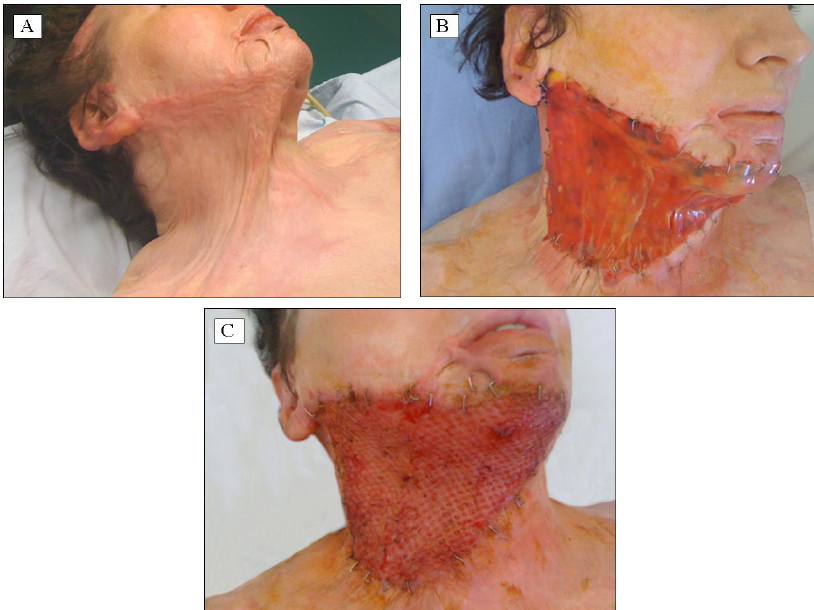
Figure 2. Case 2. A 43-year-old female patient with a 64% burned surface, IIIrd degree after chemical burn (face, neck, anterior thorax, abdomen, upper and lower limbs): ( A ) Hypertrophic scars and contractures involving the right side of the neck, one year after complete healing of burn lesions; ( B ) image of the neck skin, six days after reconstruction with Integra; ( C ) final aspect of the neck, seven days after the second stage of reconstruction (after covering with epidermal autograft).